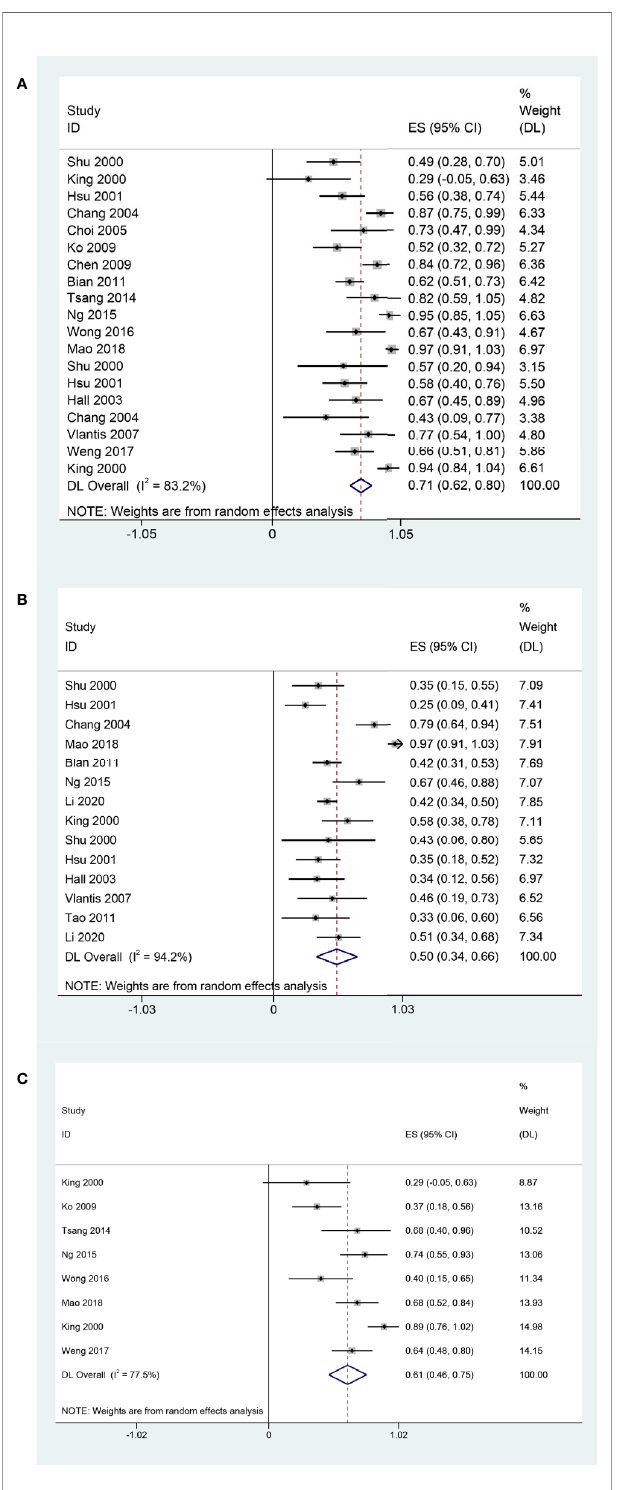
FIGURE 2 | Forest plot of meta-analysis Pooled 2-year OS (A) ; Pooled 5- year OS (B) ; Pooled 2-year DFS (C)